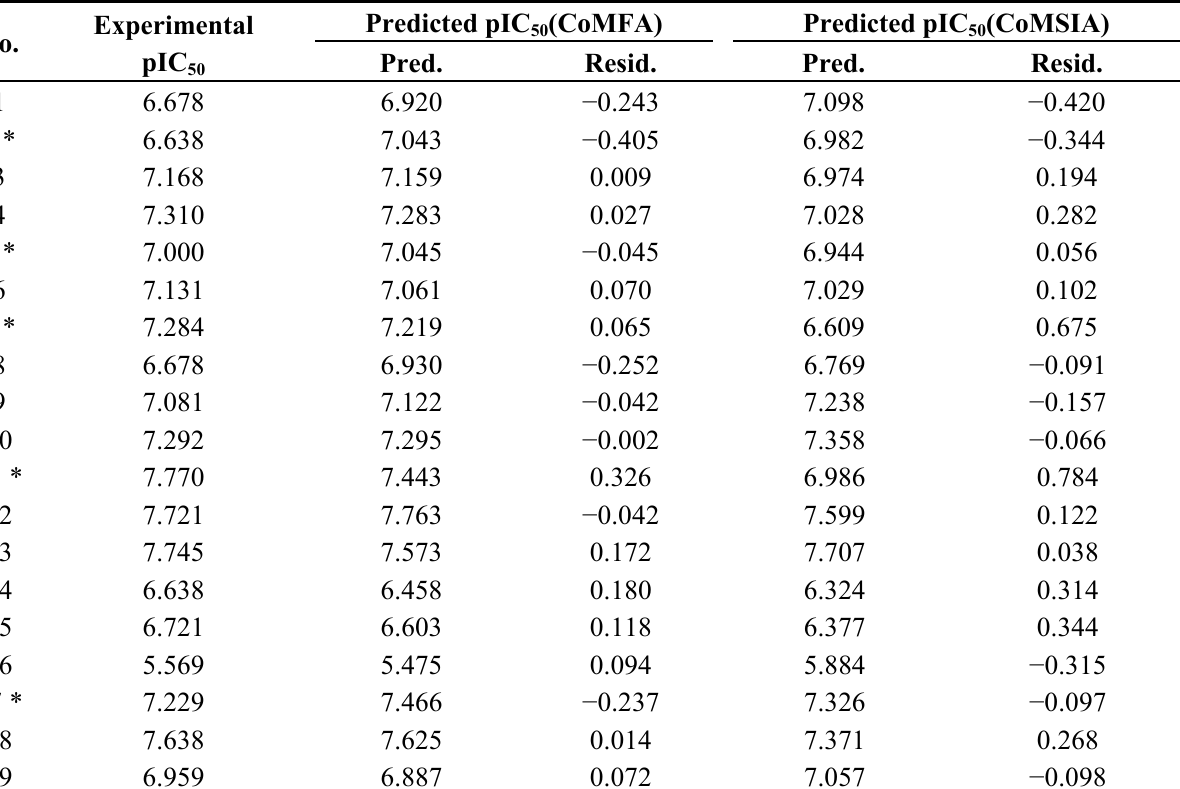
Table 2. The experimental and predicted activities (pIC CoMSIA